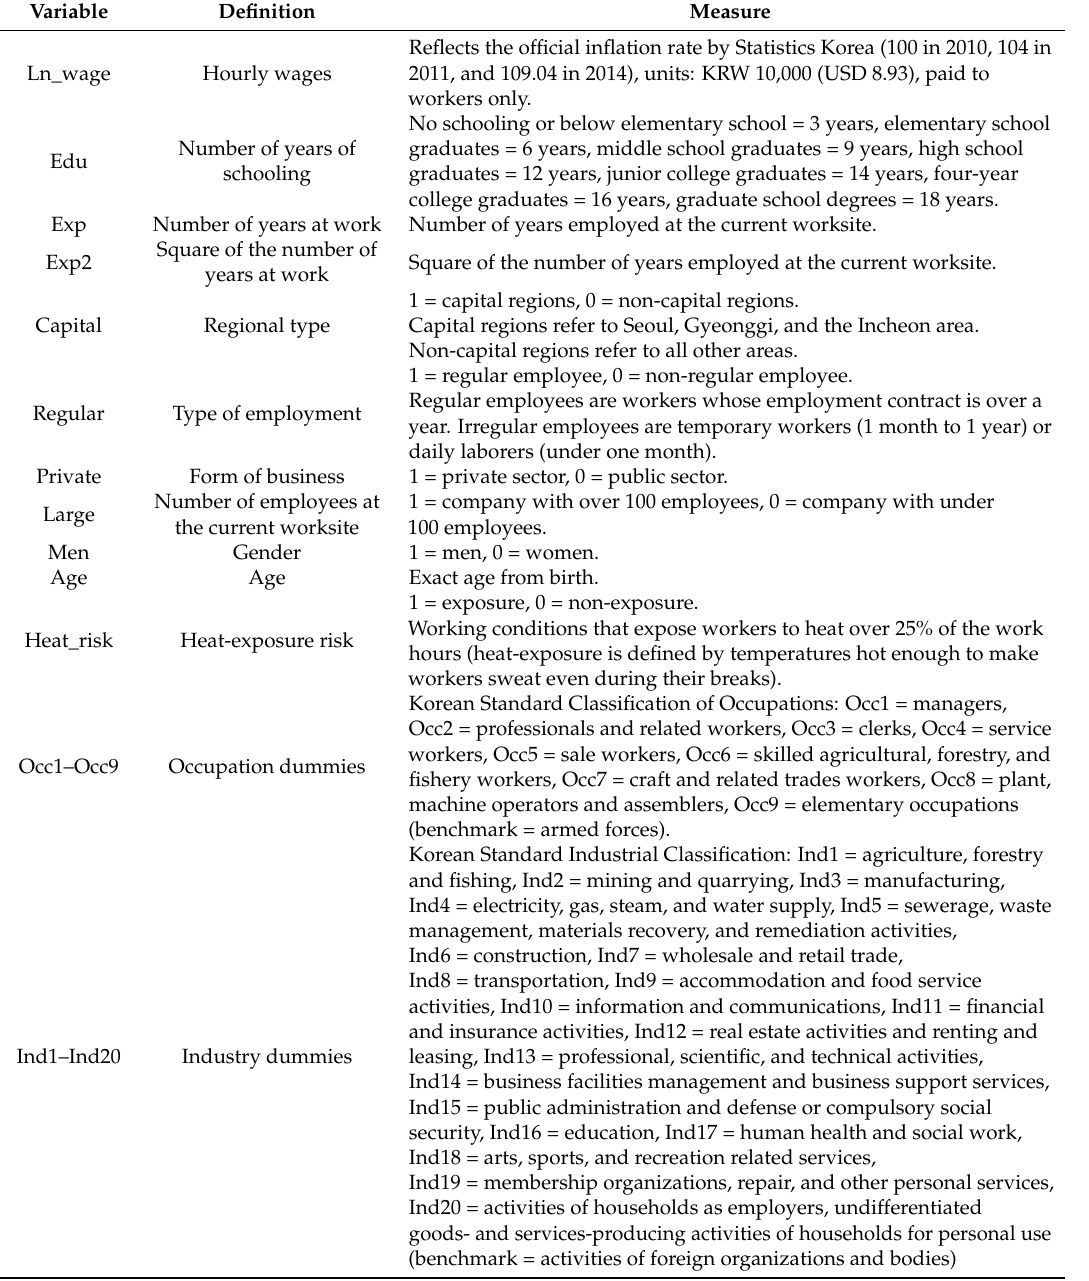
Table 1. Variable